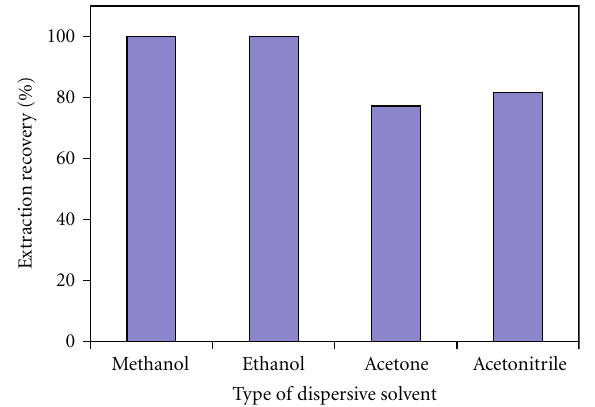
F 5: Effect of type of the dispersive solvent on the extraction recovery of copper. Extraction conditions: water sample volume,